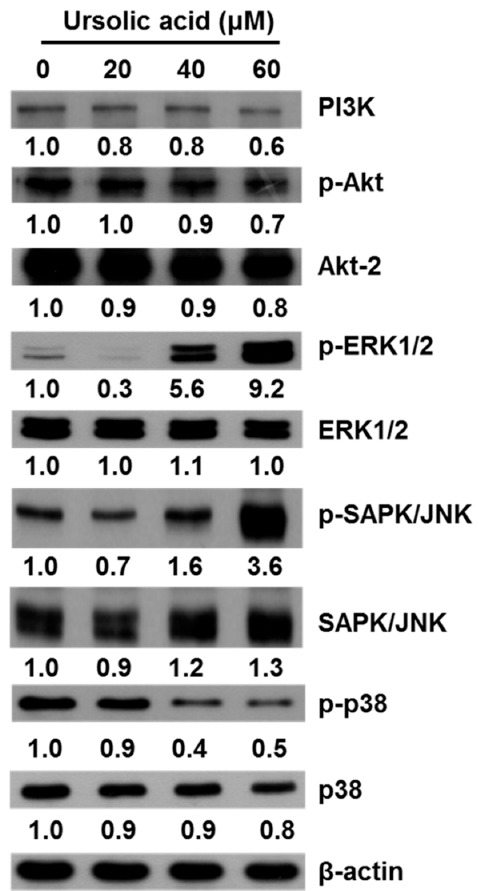
Figure 8. Effects of UA on the MAPK pathway and the PI3K/Akt pathway in SK-Hep-1 cells. The cells were treated with various concentrations of UA (0, 20, 40, and 60 μ M) for 24 h. The levels of phosphorylation of PI3K, Akt, ERK1/2, JNK1/2, and p38 were detected by western blot analysis. β -Actin served as a loading control.